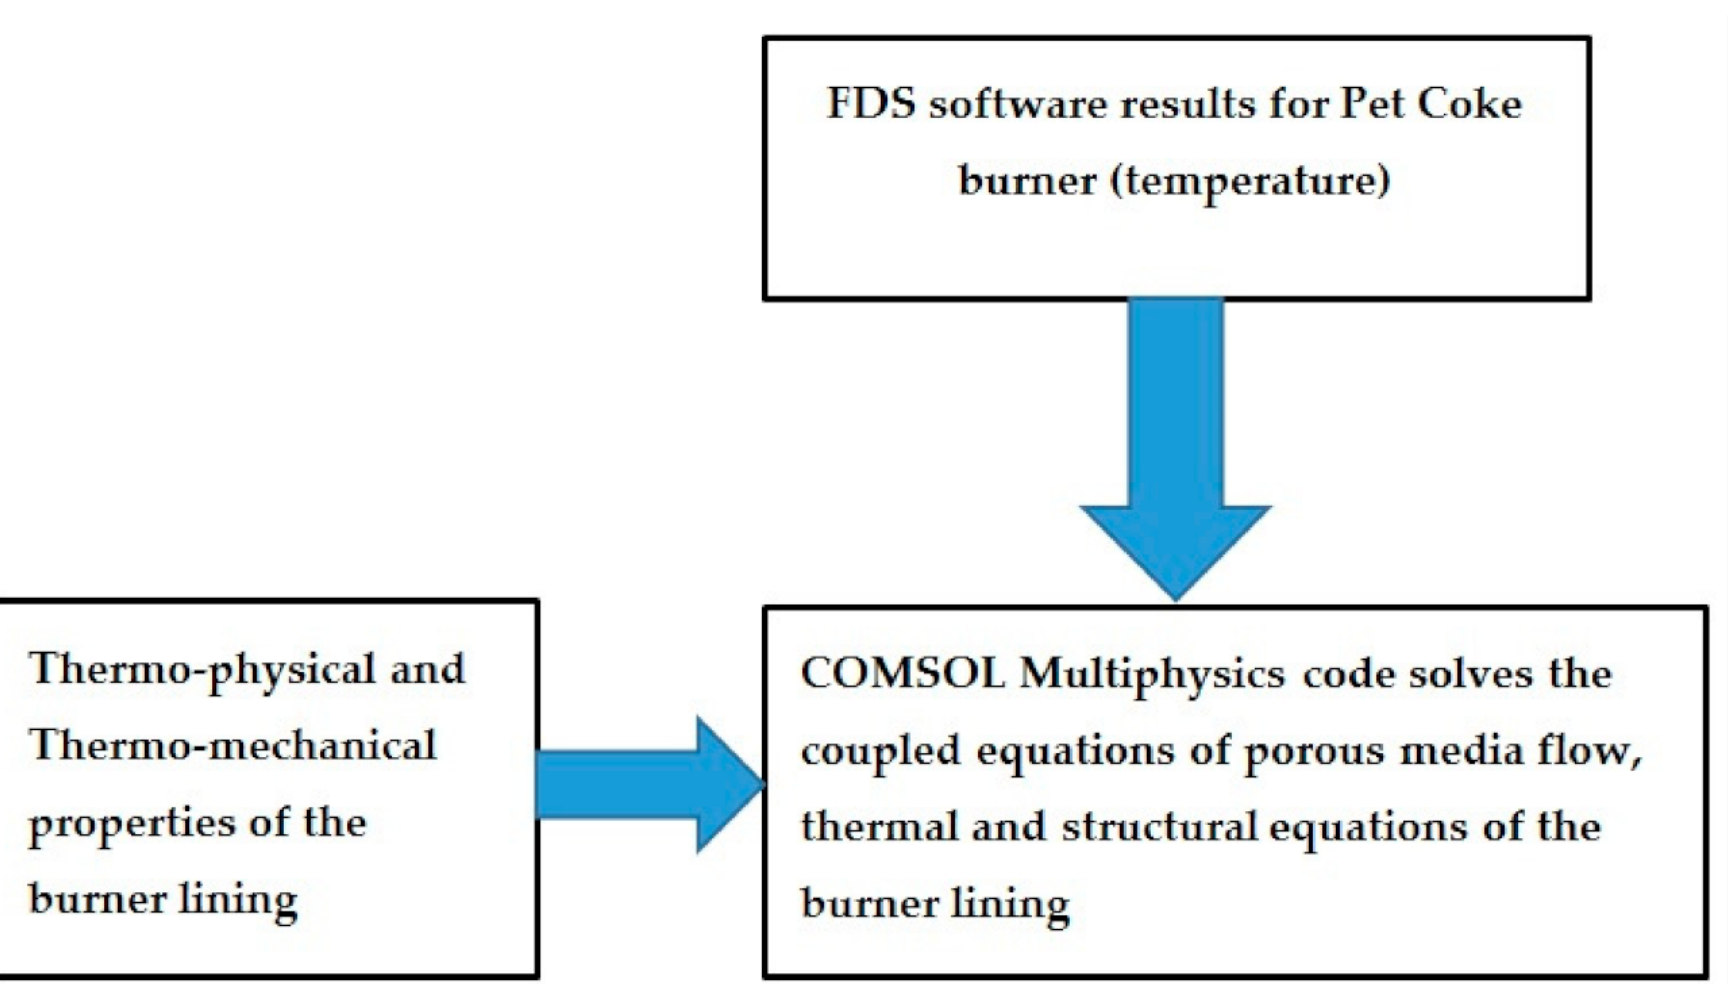
Figure 11. Schematics of the computational process of the pet-coke